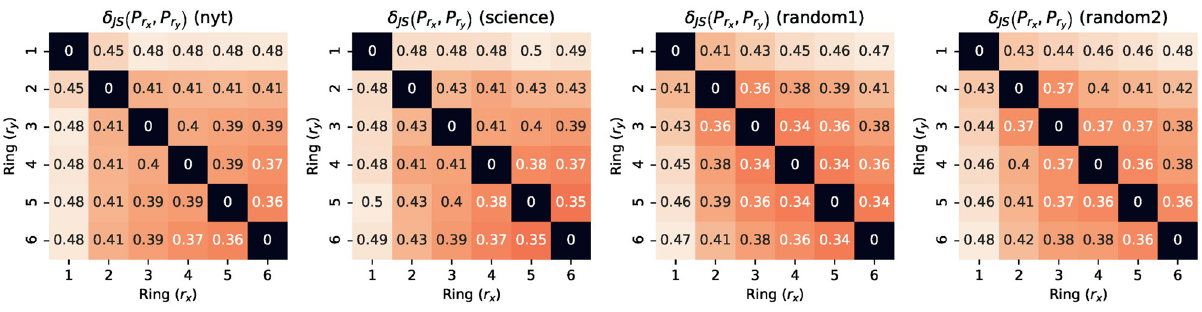
Fig 15. Jensen-Shannon distance. Average JS distance between the